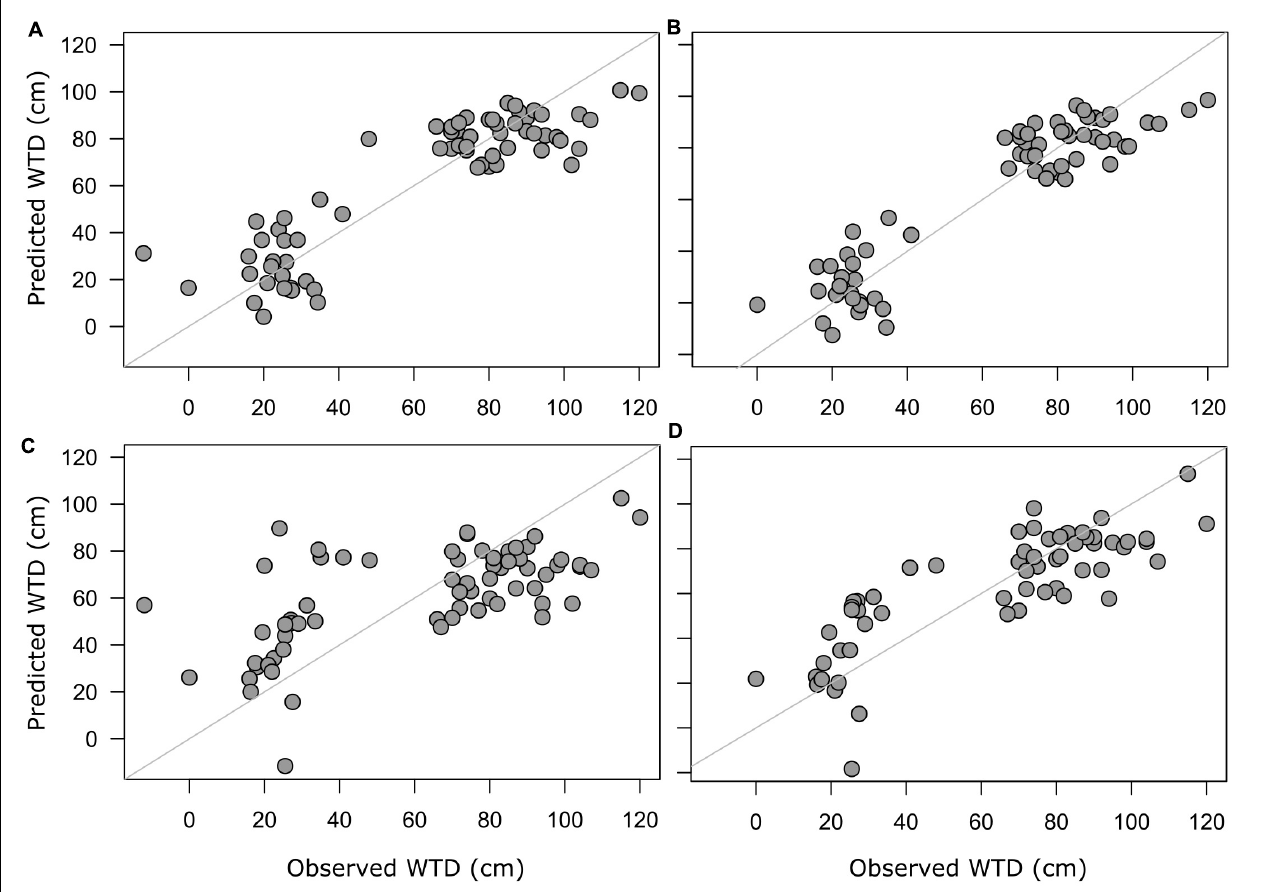
FIGURE 4 | Predicted WTD values plotted against observed WTD values. Predicted values are based on model estimates; full training set of morphotype-based WA model (A) and screened training set with the removed outliers for morphotype-based WA model (B) , the functional trait-based model (C) with selected functional traits and full training set and screened training set with the removed outliers for selected functional trait-based model (D)